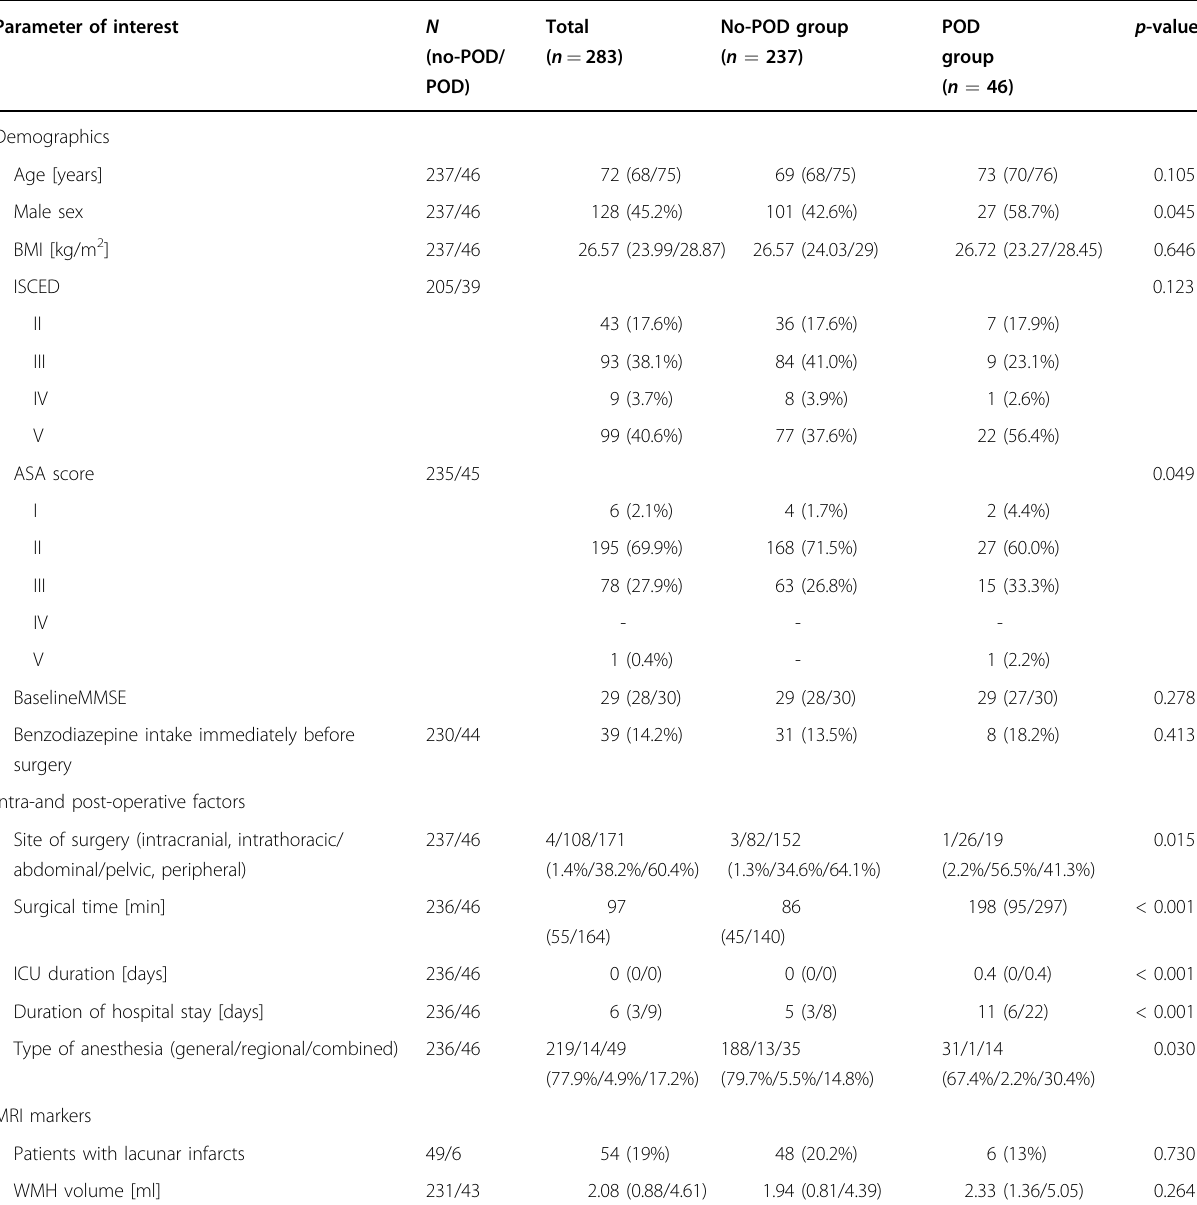
Table 1 Patient demographics and peri-operative